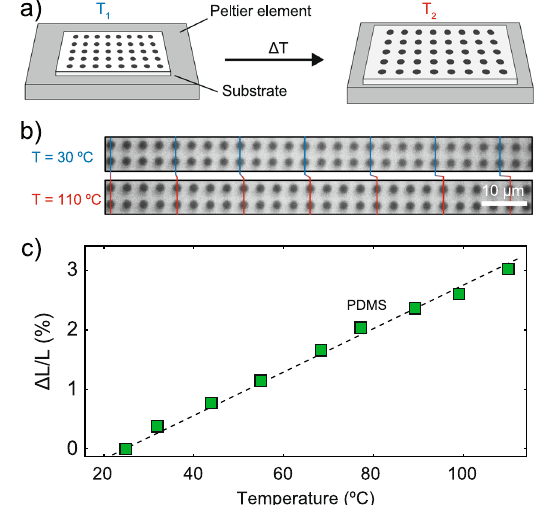
Fig. 1 a Schematic of the temperature-dependent experiment. Substrate heating (cooling) causes the thermal expansion (contrac- tion) of the substrate that induces biaxial strain on the fl ake pre- deposited on top. Control over the temperature is achieved with a Peltier heating/cooling element. b Optical microscope image (in grey scale ) of a PDMS substrate with periodic holes taken at two different temperatures (30 and 110 °C). Notice the expanded substrate at higher temperature. c Average percentage increase of the distance between holes as a function of temperature. The dashed line is a linear fi t to the data. The slope yields the expansion coef fi cient of